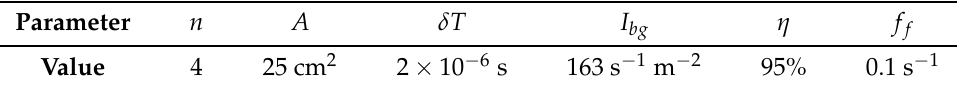
Table A2. Parameters of the considered